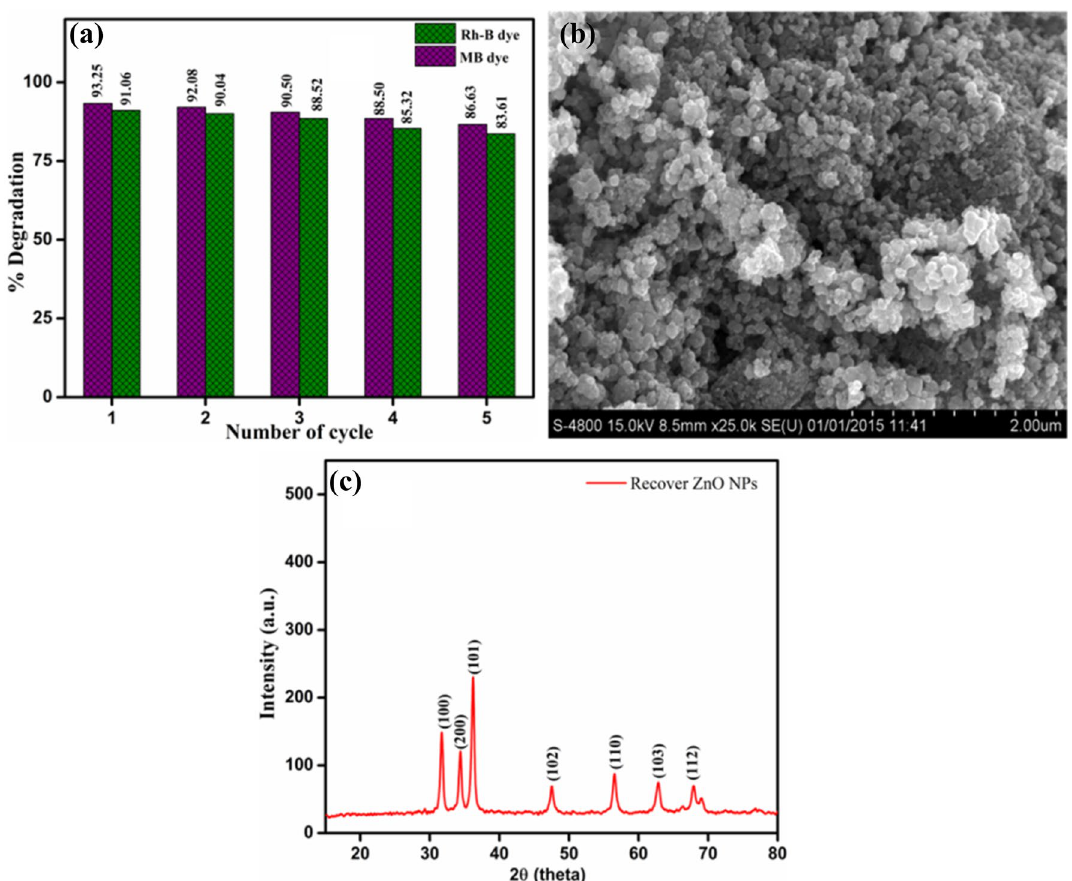
Fig. 16 a Reusability of ZnO photocatalyst, b FESEM and c XRD pattern of recovered